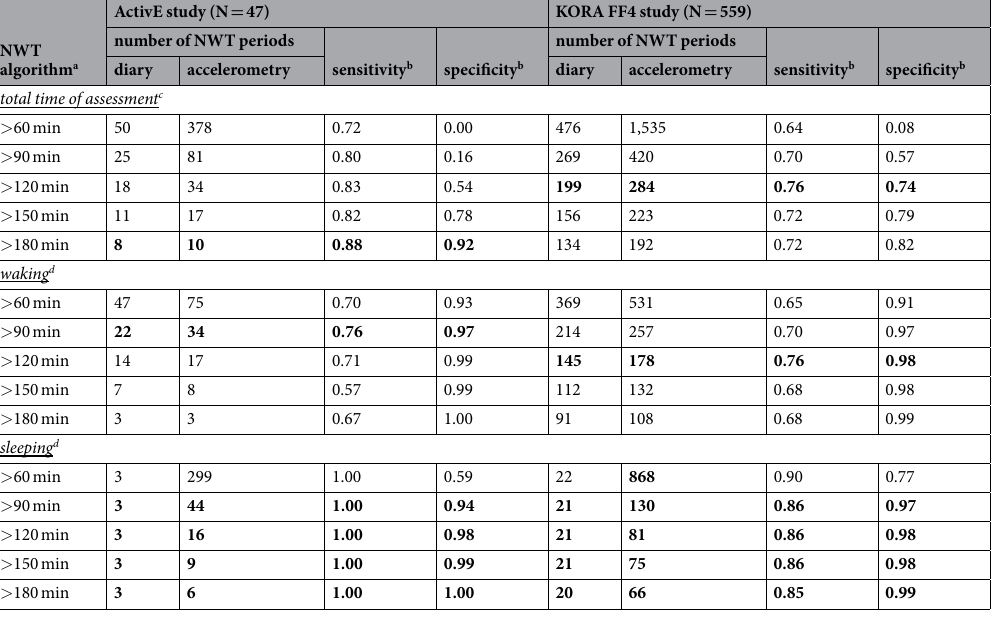
Table 2. Sensitivity and specificity: NWT algorithms > 60 to > 180 minutes using accelerometry versus diary. NWT, non-wear time. a Algorithms were applied to diary and accelerometry data to check for self-reported NWT periods > 60, > 90, > 120, > 150, and > 180 minutes or NWT periods based on consecutive acceleration zero-counts > 60, > 90, > 120, > 150, and > 180 minutes, respectively. b Periods with an overlap between NWT according to diary and accelerometry of ≥ 50% were included in this analysis; number of epochs with an overlap of < 50% was: in ActivE, waking, 90-min algorithm: 1; in KORA FF4, total time, 60- to 180-min algorithm: 30, 7, 8, 5, and 4, respectively; in KORA FF4, waking, 60- to 180-min algorithm: 14, 4, 5, 2, and 1, respectively; in KORA FF4, sleeping, 60-min algorithm: 1. c Analyses were conducted from the first to the last recorded time point of assessment in the diary. d Waking and sleeping phases were derived from participants’ diary entries. bold : algorithms showing high sensitivity and specificity in ActivE and KORA FF4,